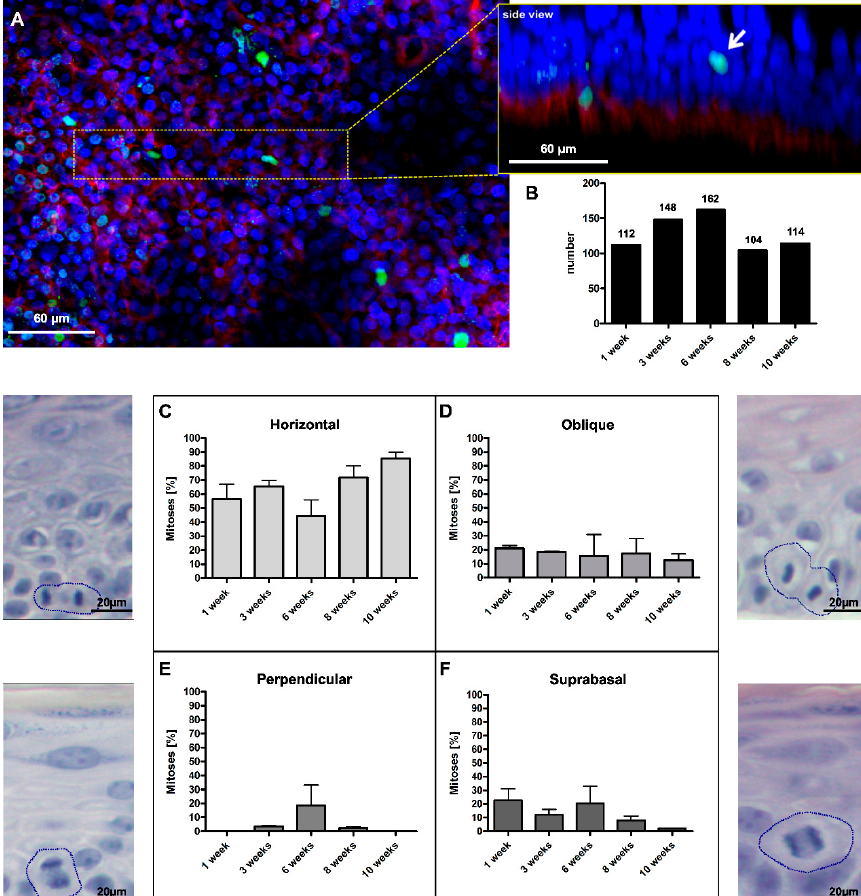
Figure 1. Four different types of mitoses were found in the human skin equivalent. ( A ) Whole mounts of the SE were stained with anti-integrin α 6 (red) and anti-H3S10ph (green) and confocally analyzed to visualize the localization and angle of mitotic events. The insert represents the 3D reconstruction of the magnified tissue piece, seen from the side, the white arrow indicates a suprabasal mitotic cell; ( B ) In total, 640 mitotic events were counted at culture time points ranging from 1–10 weeks; ( C ) 40%–80% of mitoses occurred horizontally to the BM; ( D ) 10%–20% of cells divided at an oblique angles; ( E ) up to 20% of divisions were perpendicularly oriented to the BM; and ( F ) up to 20% of divisions occurred suprabasally. Error bars in ( C – F ): standard error of the mean (SEM) of three individual culture experiments. The accompanying micrographs in ( C – F ) illustrate the histological appearance in H&E-stained sections. Circles mark dividing cells.